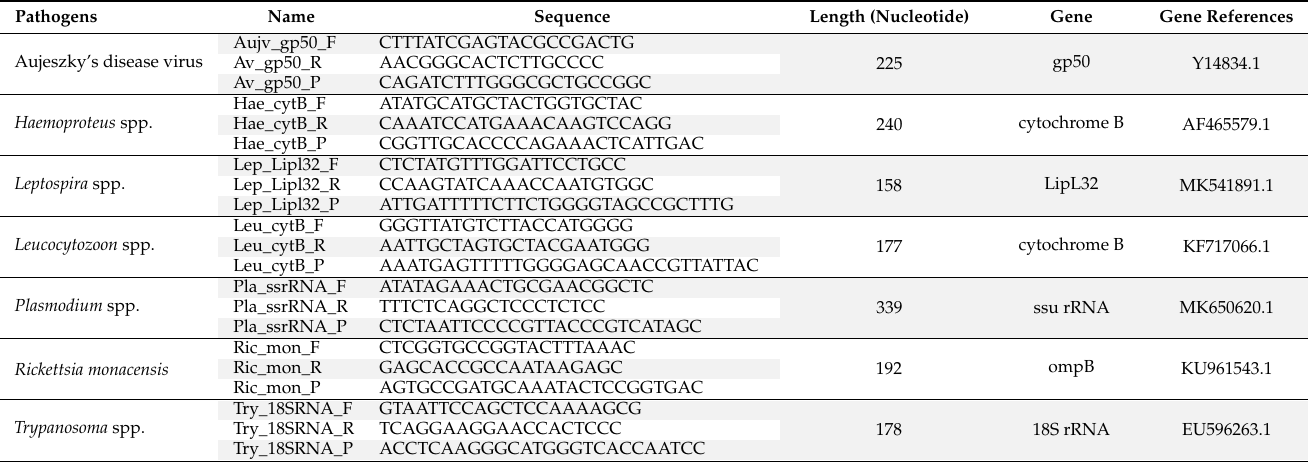
Table 1. List of pathogens, targets, and primer/probe sets created for microfluidic real-time PCR